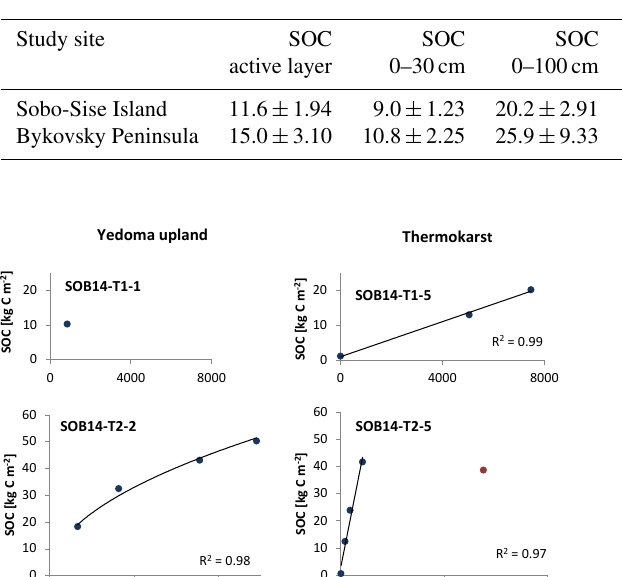
Table 2. Mean landscape soil organic C and N storages in kgm − 2 ± 95% confidence interval.